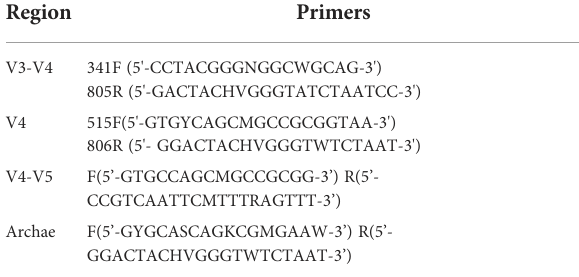
TABLE 1 Ampli fi ed primer